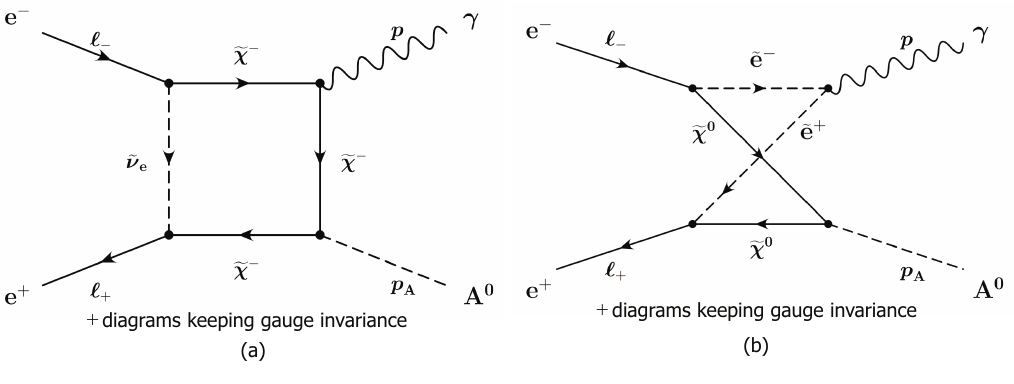
Figure 5: Possible box-diagrams in the MSSM: (a)Chargino( ˜ χ − )-sneutrino(˜ ν contribution and (b)Neutralino( ˜ χ 0 )-selectron(˜ e − )-box